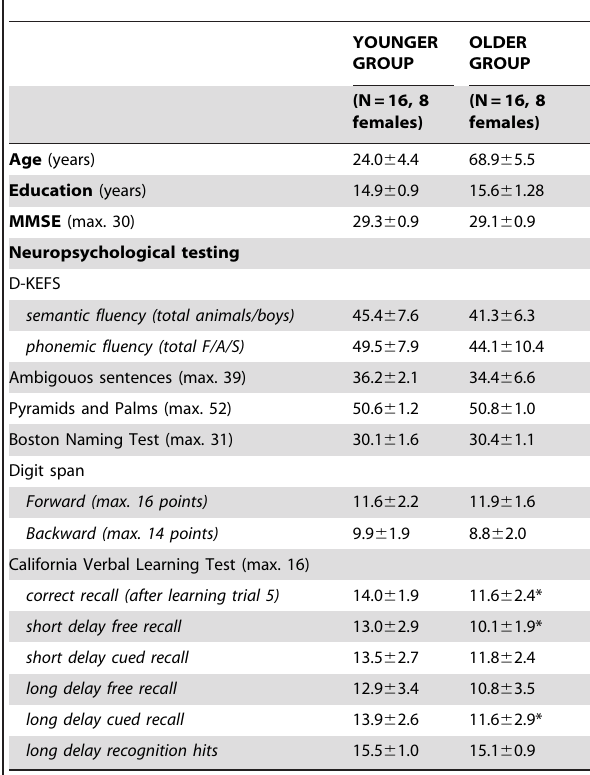
Table 1. Demographic and psychometric characteristics of the